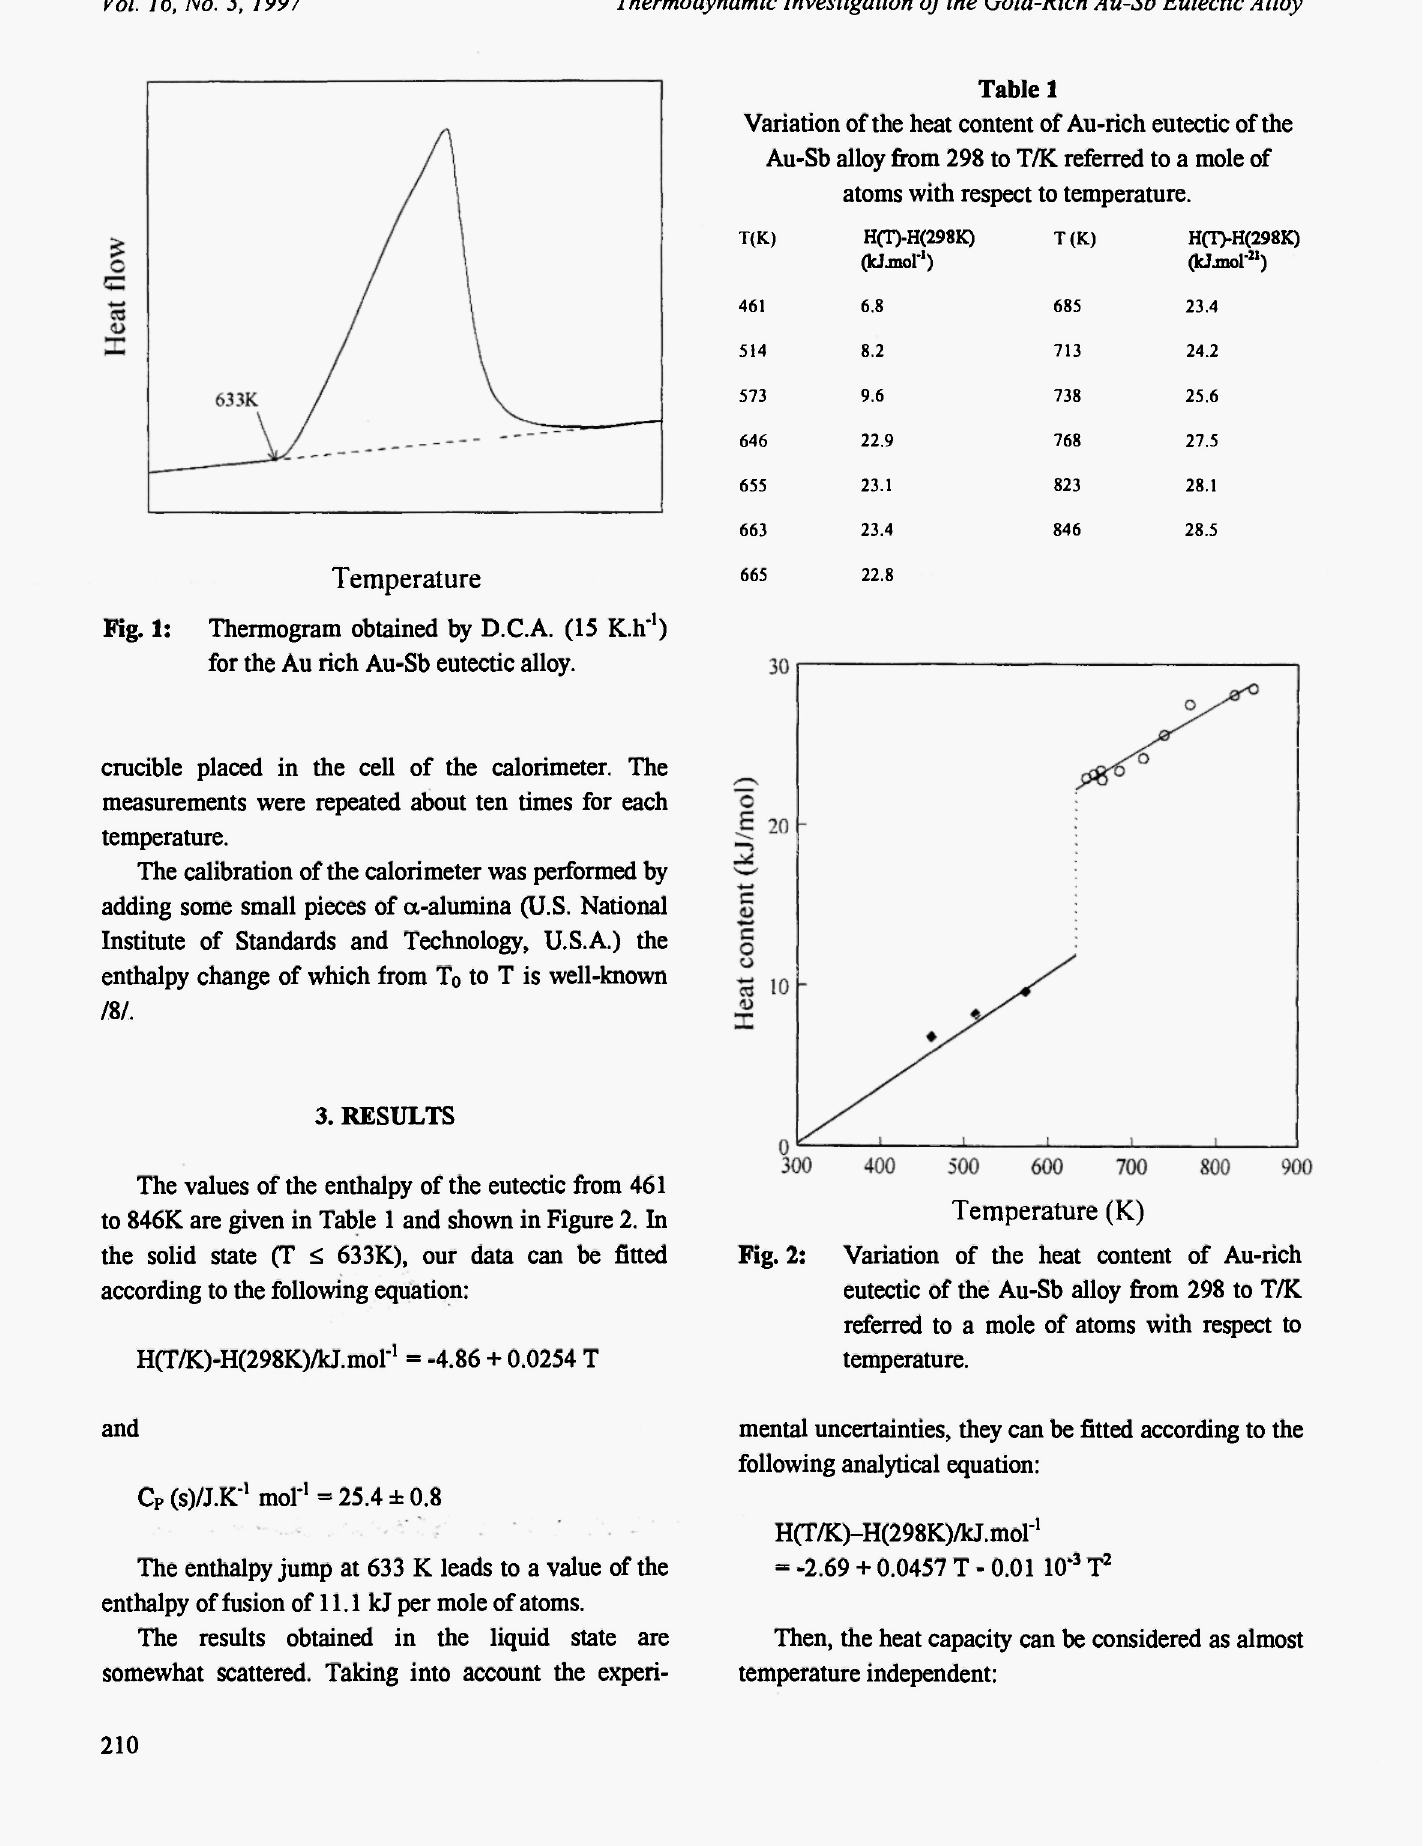
Variation of the heat content of Au-rich eutectic of the Au-Sb alloy from 298 to T/K referred to a mole of atoms with respect to temperature.